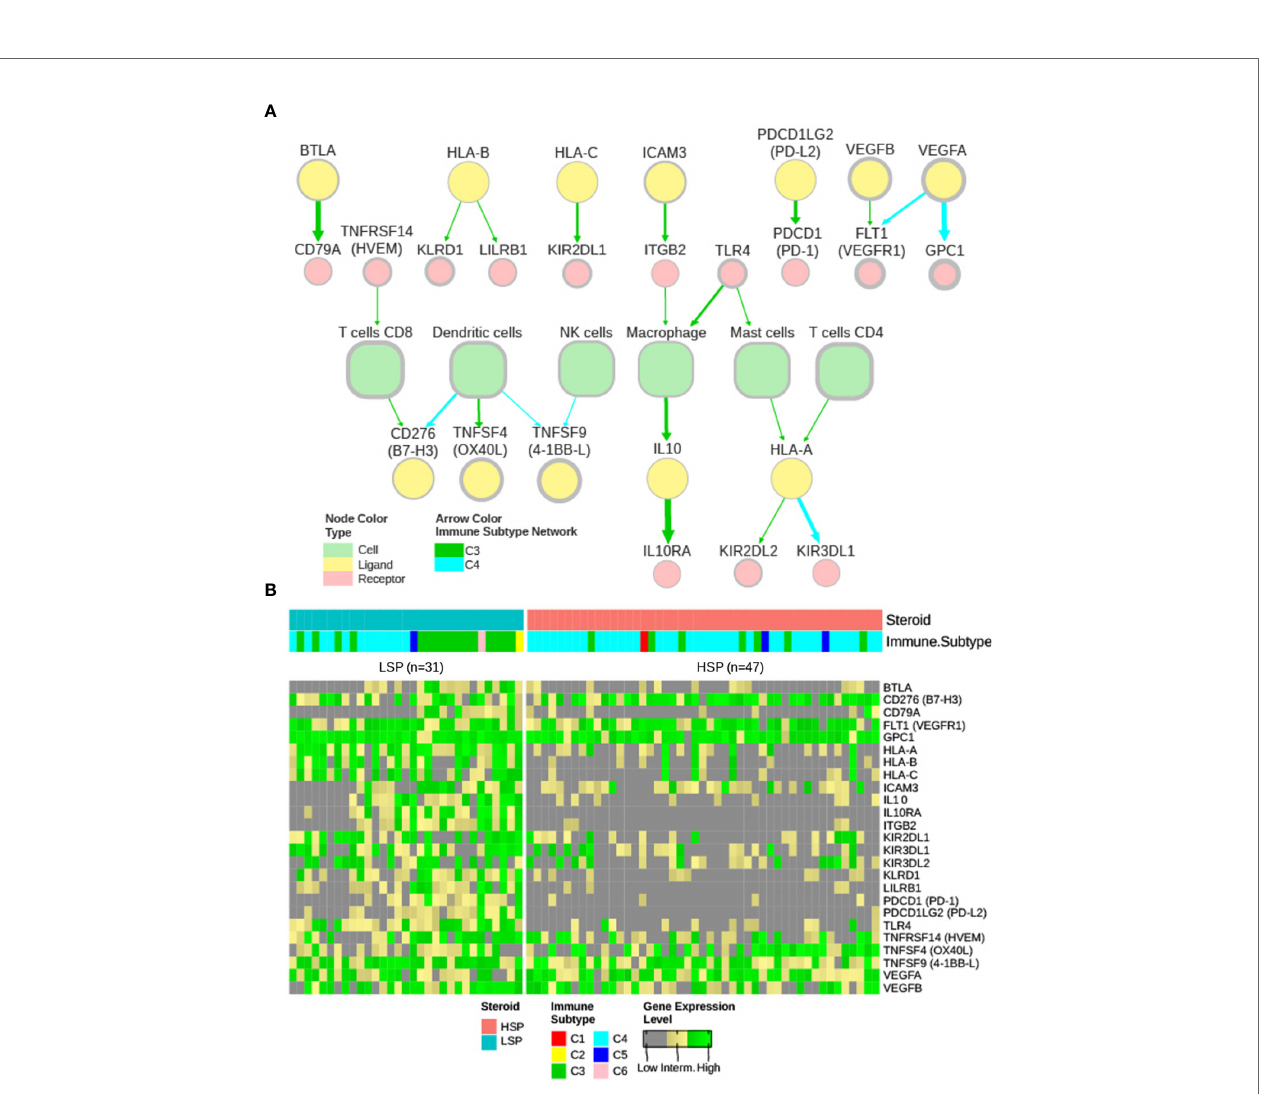
FIGURE 7 | iAtlas explorer-extracellular communication network. (A) The extracellular communication network according to Thorsson et al. (11) and available on CRI Atlas (https://isb-cgc.shinyapps.io/shiny-iatlas/) was reconstructed for the C3 and C4 patients of TCGA ACC cohort. Nodes with greater than 50% abundance and a concordance interaction larger than 2.5 were selected. The node line width varies proportionally to abundance and the edge width varies proportionally to concordance. Green arrows represent interactions of C3 patients and cyan arrows represent interactions of C4 patients. Node colors represent immune cells (light green), receptors (pink), and ligands (yellow). (B) The receptors and ligands present in the network were evaluated based on gene expression levels in a pan-cancer comparison. Gene expression of the 25 nodes in the network were ranked among 9,361 primary tumor samples available in the TCGA database and classi fi ed as low (grey), intermediate (yellow), or high (green) expression level based on ranking terciles. Each column represents a patient with ACC. Column order is maintained from Figures 5A and 6A heatmaps. Steroid phenotype and immune subtype classi fi cations are indicated in the top